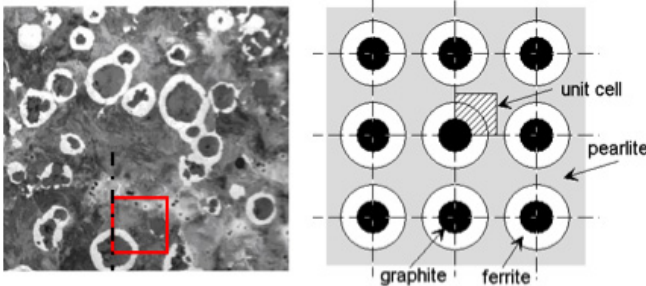
Figura 4: Schema di modellazione a cella unitaria della microstruttura di una ghisa nodulare